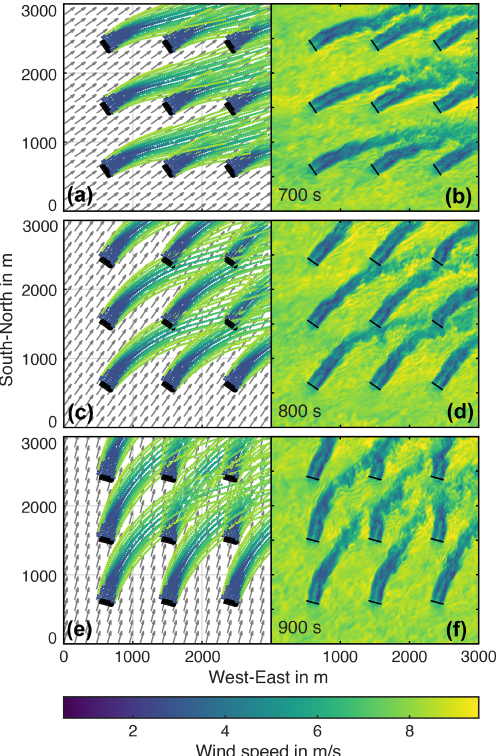
Figure 10. Nine-turbine flow field at hub height during the wind direction change at t = 700s (a, b) , t = 800s (c, d) and t = 900s (e, f) . The FLORIDyn flow field is on the left and includes grey arrows as an indicator of the current wind direction. On the right is the corresponding snapshot from the SOWFA